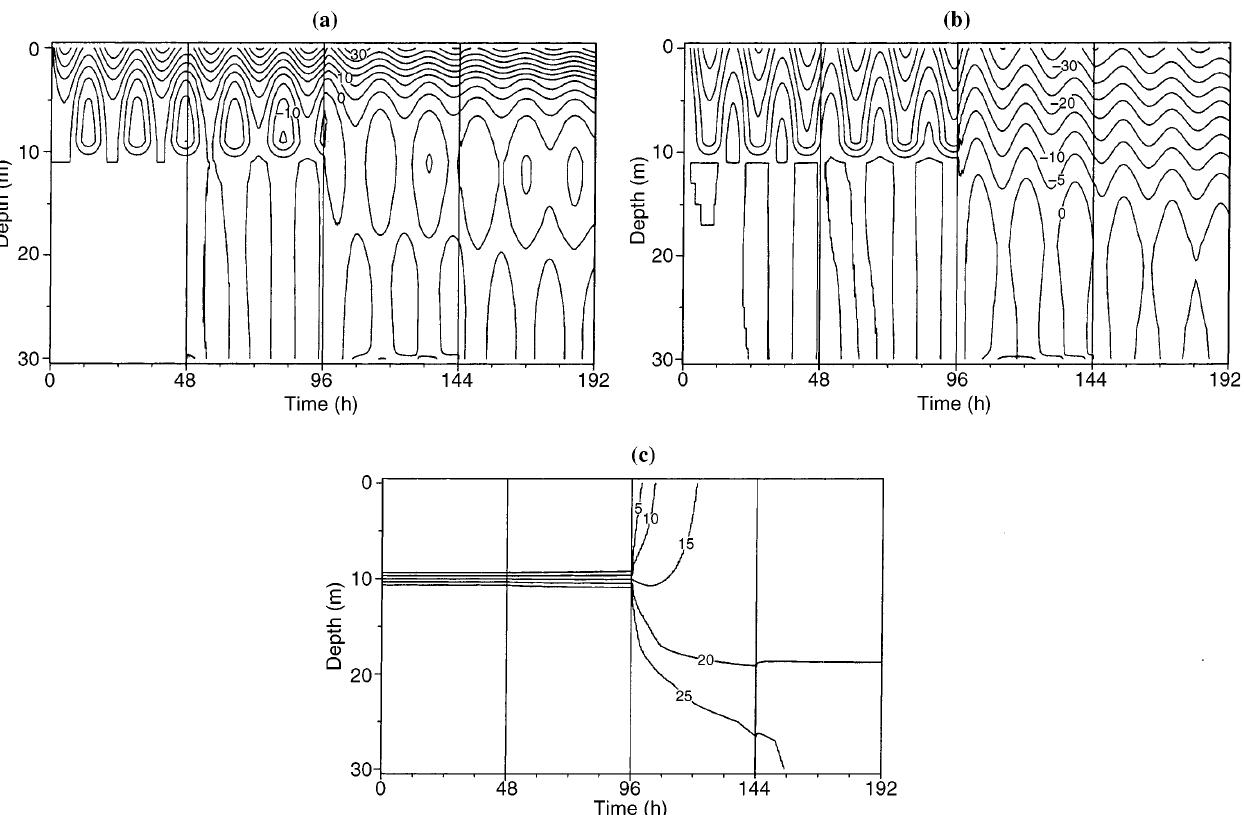
Fig. 5a–c. Optimal solution obtained by the assimilation of sequential and noised data (48 h, 96 h, 144 h and 192 h). a Velocity u (cid:133) cm (cid:1) s (cid:255) 1 (cid:134) , b velocity v (cid:133) cm (cid:1) s (cid:255) 1 (cid:134) , c salinity (psu). The contour intervals are 5 units for each variable